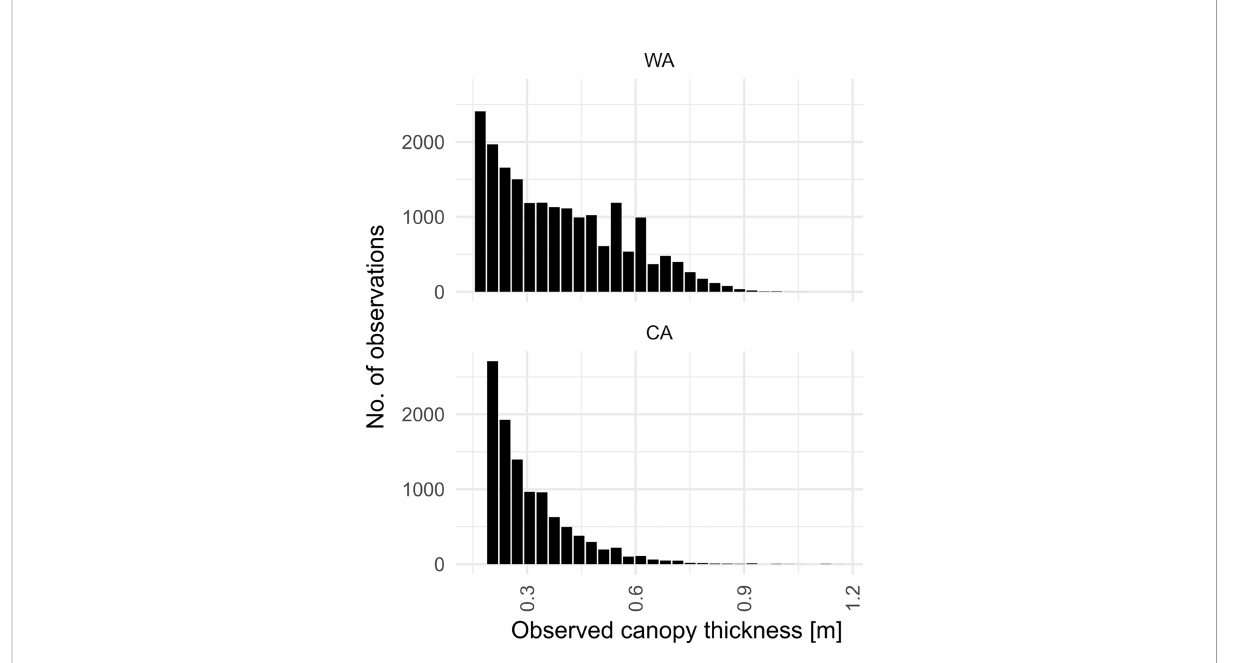
FIGURE 5 Histograms of canopy thickness observed at studied sites.